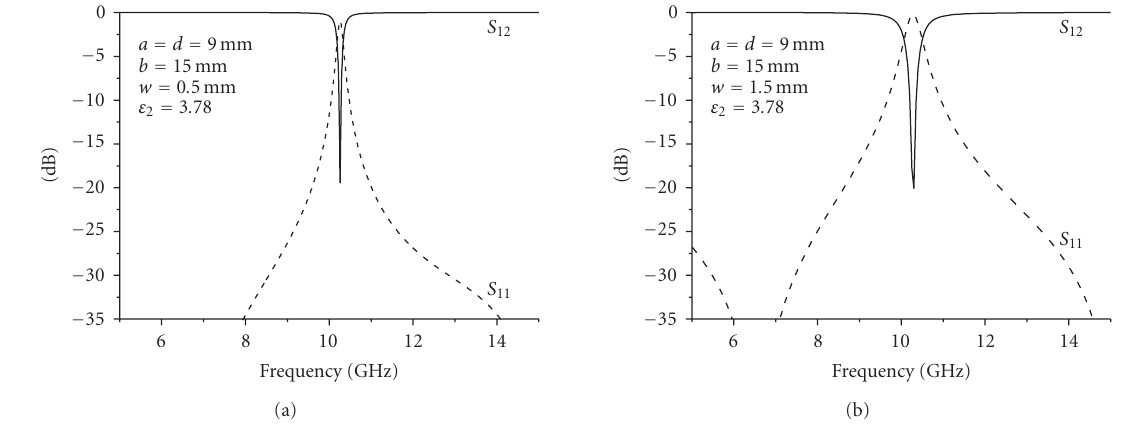
Figure 4: Amplitude-frequency characteristics of the band-rejection element in the case of the half-wave resonance.